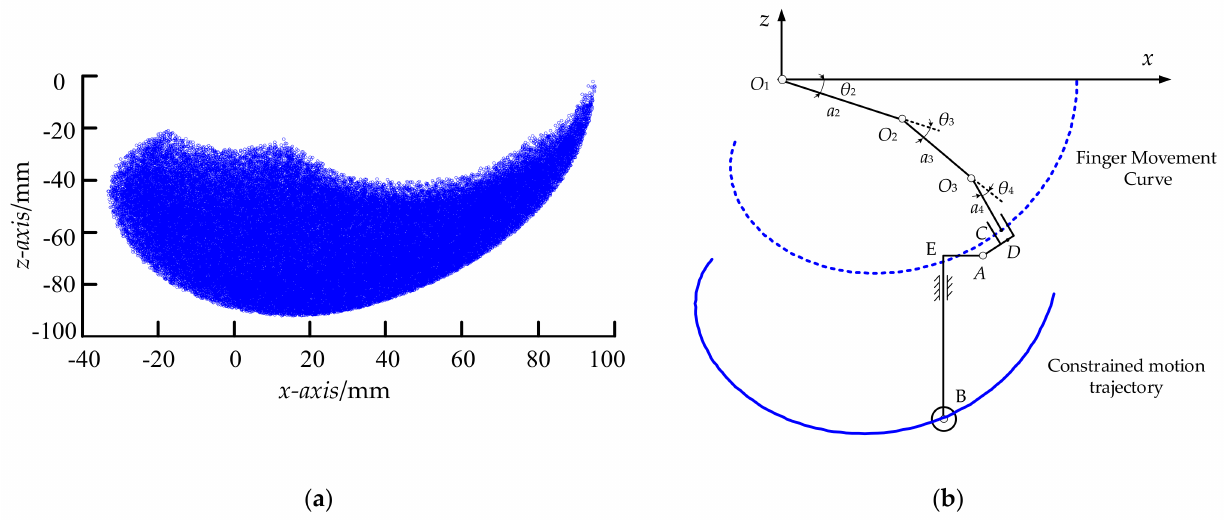
Figure 3. ( a ) The range of motion for the index finger in its natural state; ( b ) a sketch of the cam structure that reproduces the natural motion of the